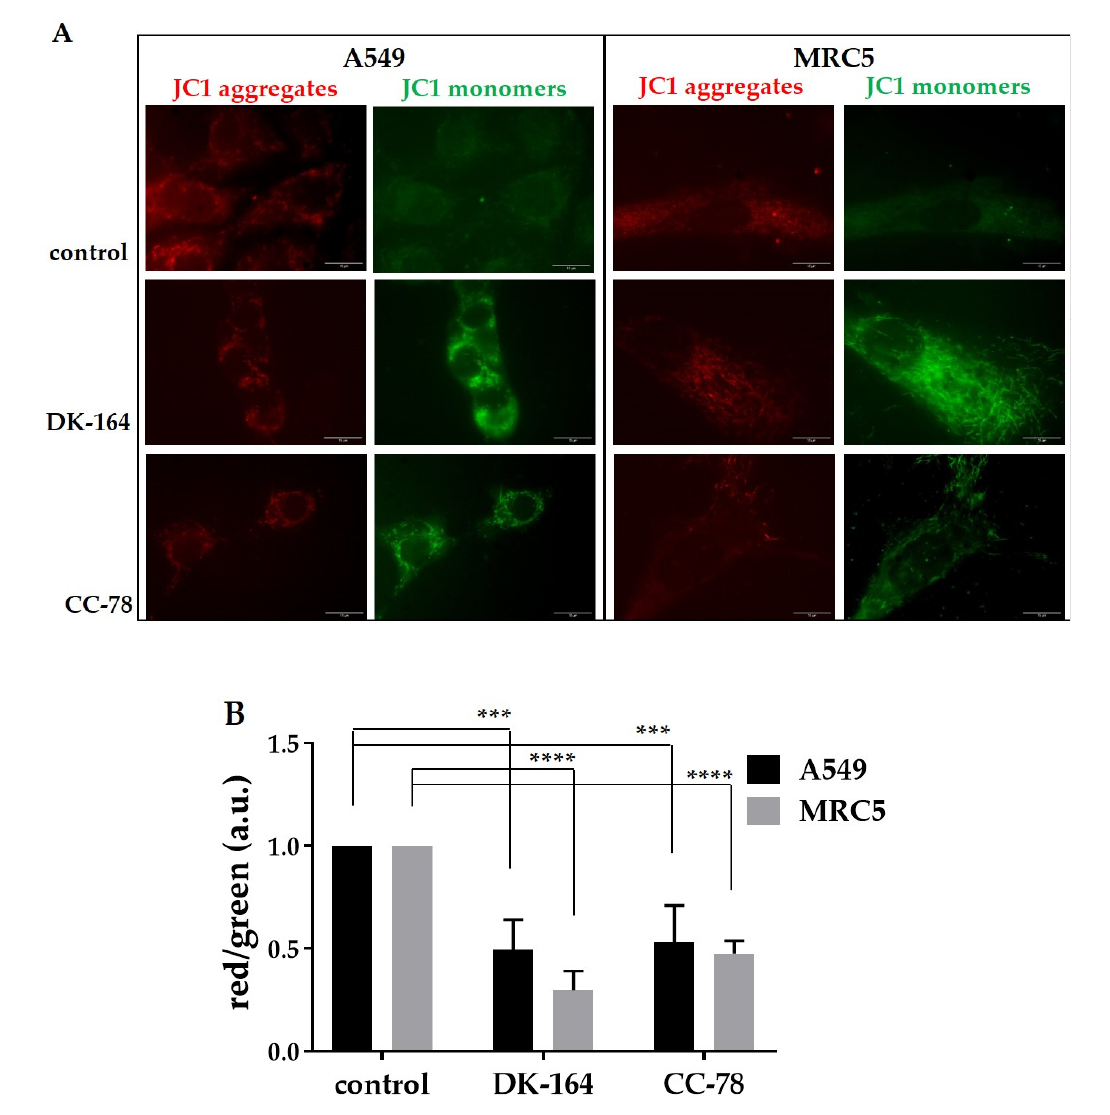
Figure 9. Detection of mitochondrial membrane potential by JC-1 staining. ( A ) Mitochondrial membrane depolarisation after treatment of A549 and MRC5 cells with IC25 of DK-164 and CC-78. Representative immunofluorescent images of control and treated cells for 24 h were visualised by JC-1 staining. The scale bar corresponds to 15 µ m. ( B ) Quantification of the ratio of red signal (JC1 aggregates) to green signal (JC1 monomers), normalised to the intensity of the signal in non-treated control cells. Probability values were considered significant at the *** p < 0.005, and **** p < 0.001. The error bars represent the standard deviation (SD). a.u.: arbitrary unit. Bar graphs represent the means of three independent experiments.